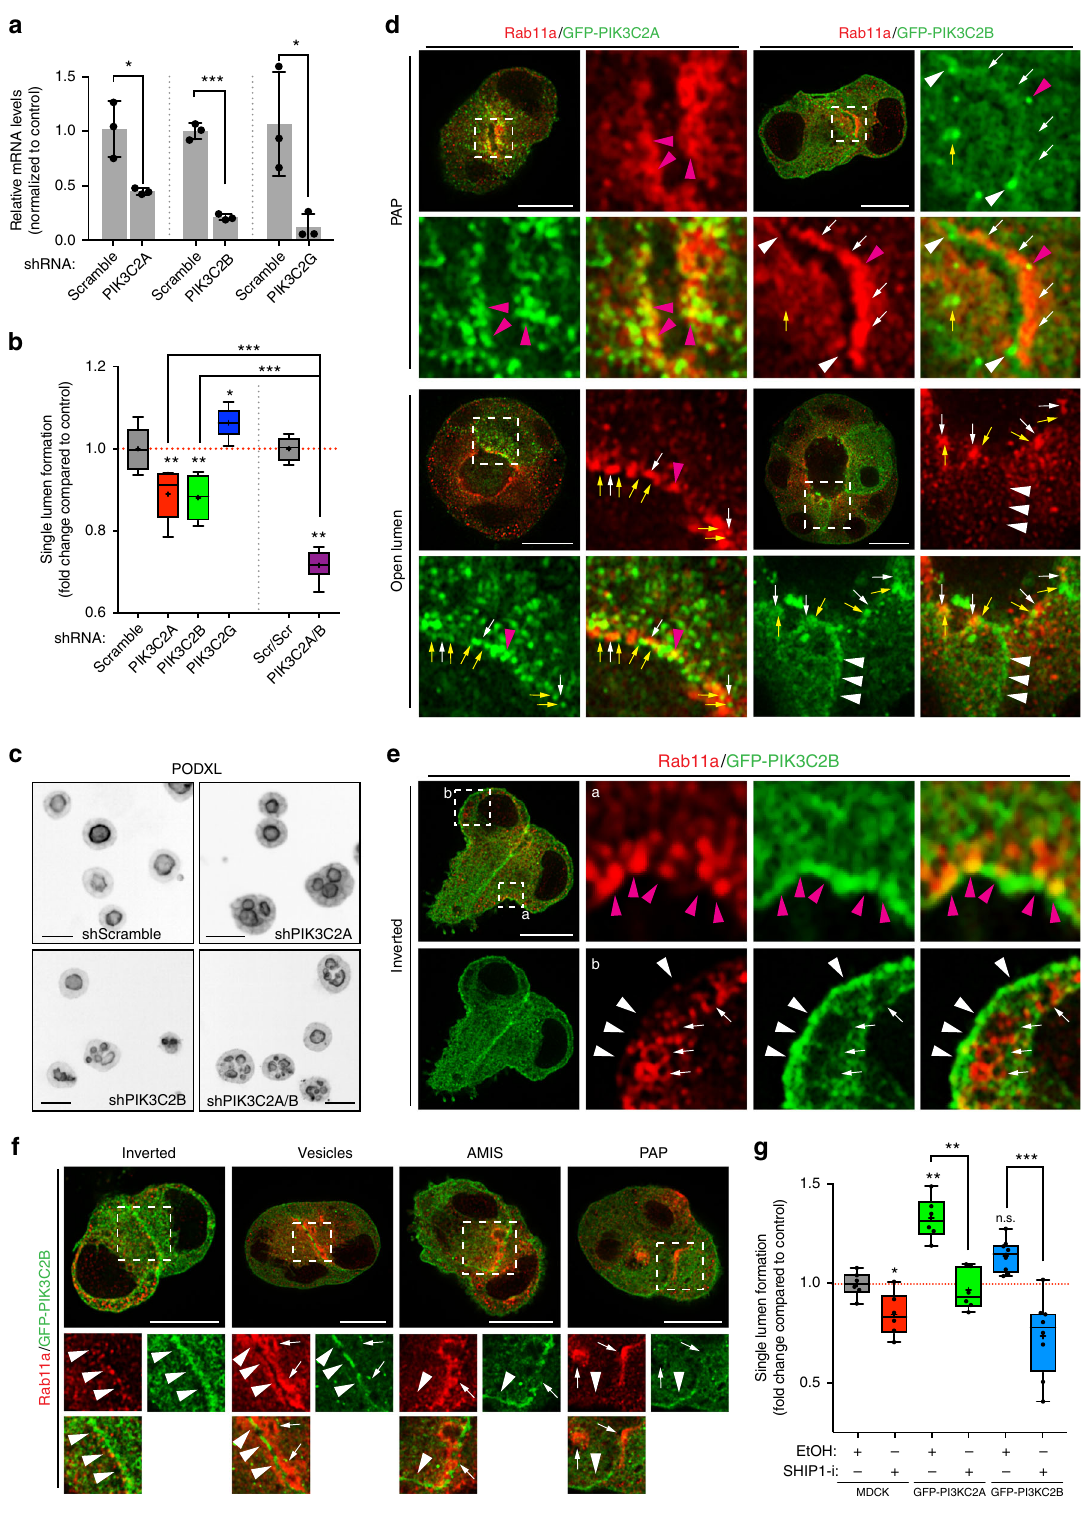
32 °C. Upon changing to fresh medium, cells were incubated for a further 48 h at 37 °C, before passage into appropriate antibiotic-containing medium. Hygromycin (0.5 mg ml − 1 ), blasticidin (12.5 μ g ml − 1 ), puromycin (5 μ g ml − 1 ), or zeocin (0.4 mg ml − 1 ) were used.